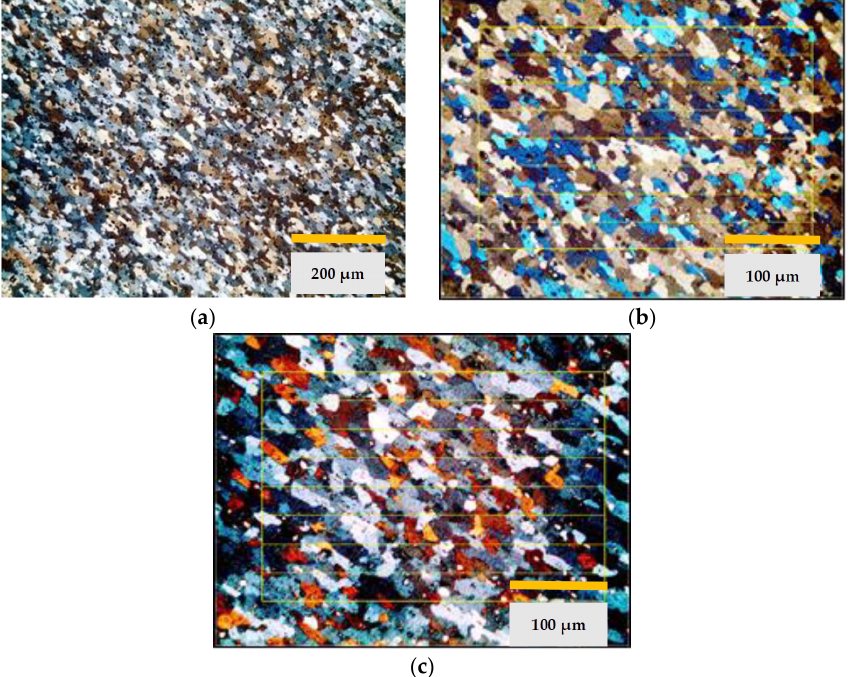
Figure 3. Metallographic images of EN-AW 5754, ( a ) microstructure in the supply state; ( b ) microstructure after thermal cycle 1; ( c ) microstructure after thermal cycle 2 .